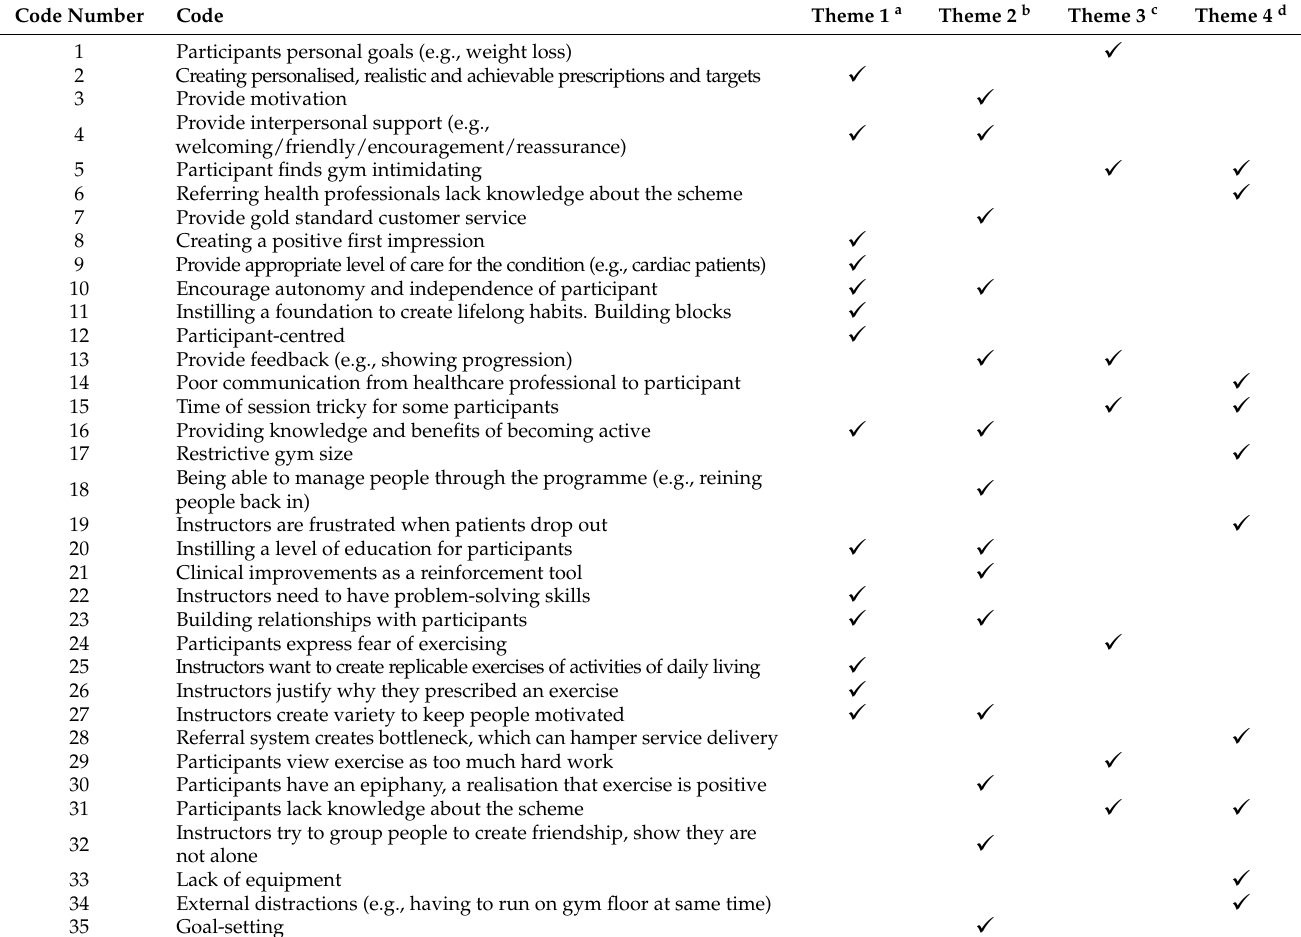
Table 1. Coding and descriptive themes of exercise referral instructor’s perspective of motivating and supporting uptake attendance and adherence to exercise referral schemes.